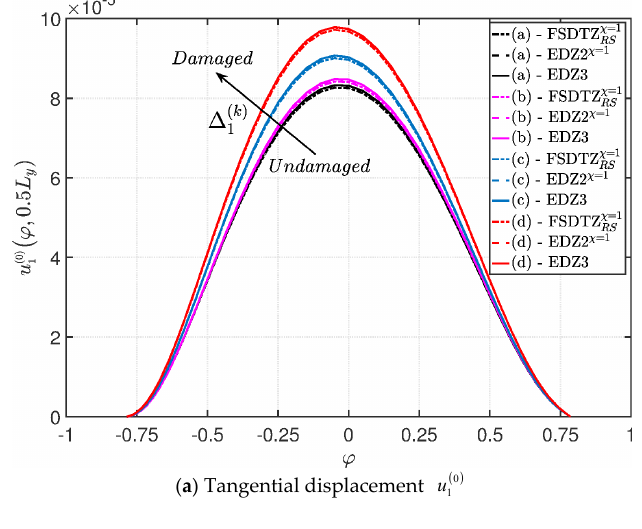
(Figure 20a) and the vertical one (Figure 20b) increase when the damage affects wider areas, as expected. Similar graphs are obtained by the various HSDTs. The through-the-thickness variations of strains, stresses, and three-dimensional displacements are depicted respectively in Figures 21–23, where the so-called zig-zag effect is clearly observable. In general, comparable profiles are obtained  provides curves that are slightly through all the structural models, even though the 1 FSDTZ RS detached, especially when the plotted quantities present a lower order of